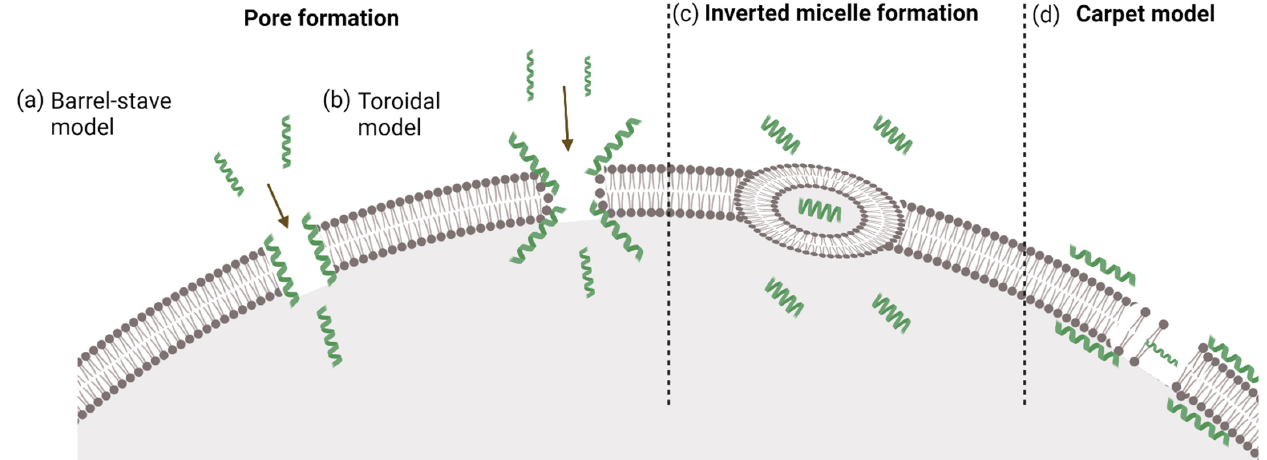
Figure 1. Direct translocation models discussed so far: ( a ) the barrel-stave model; ( b ) the toroidal model; ( c ) inverted micelle formation; ( d ) the carpet model.